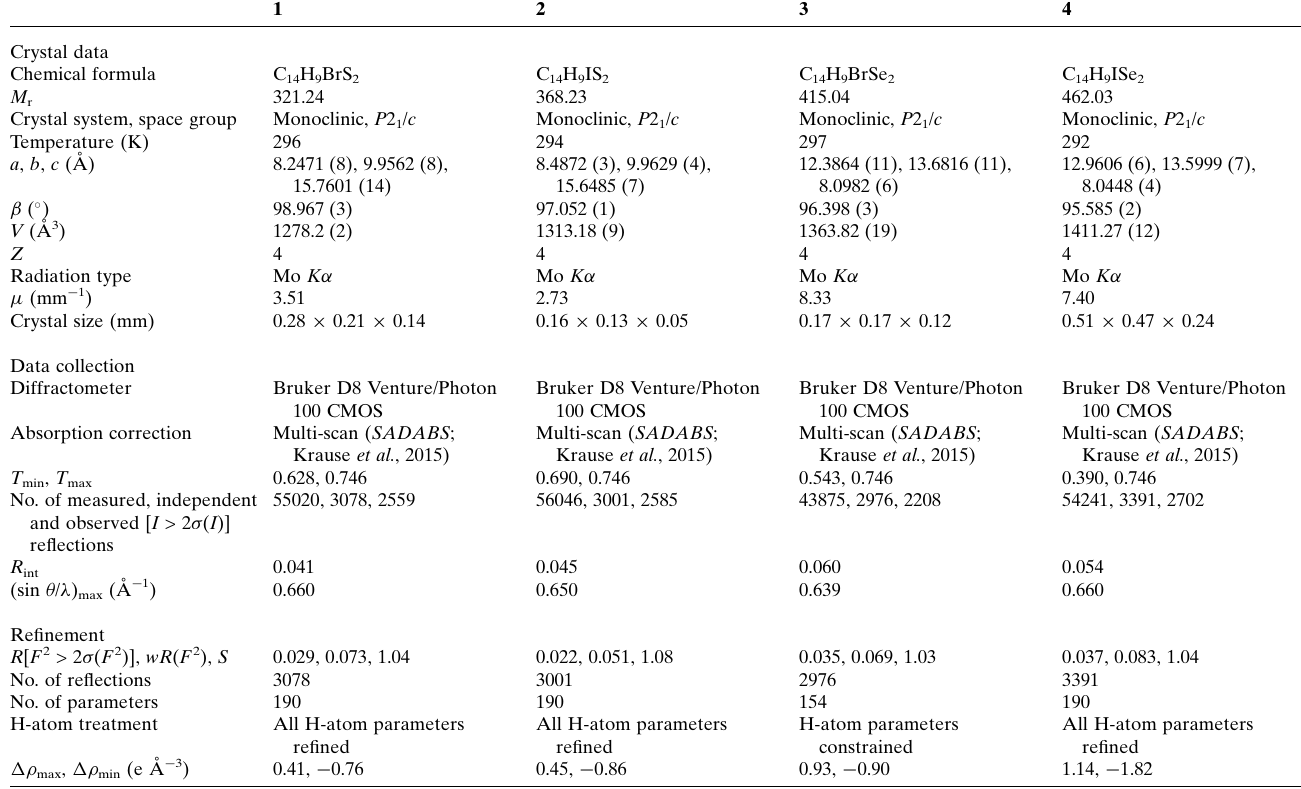
Table 1 Experimental